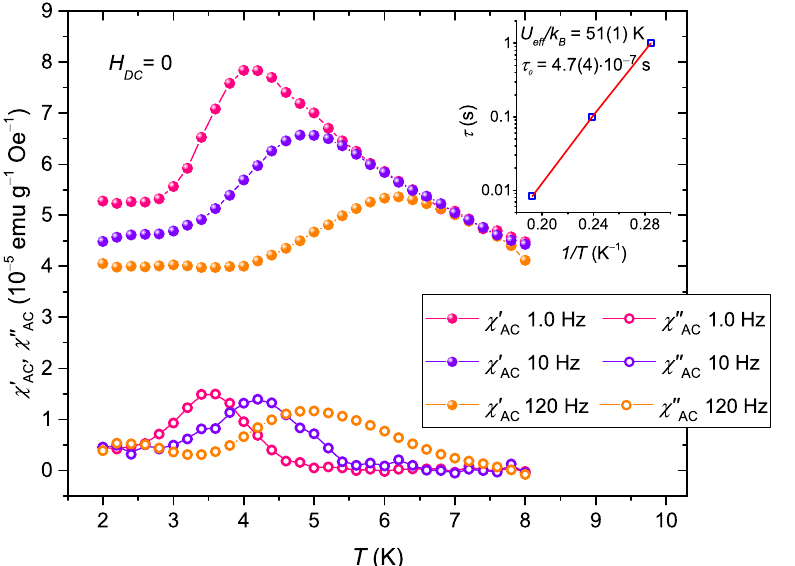
Figure 3. Temperature dependence of in-phase and out-of-phase susceptibility at various frequencies in the zero static field for the sample SilS-Mn 12 (lines are a guide for eyes) (inset: corresponding relaxation times in function of inverse temperature (solid line stands for the best fit to the Arrhenius function